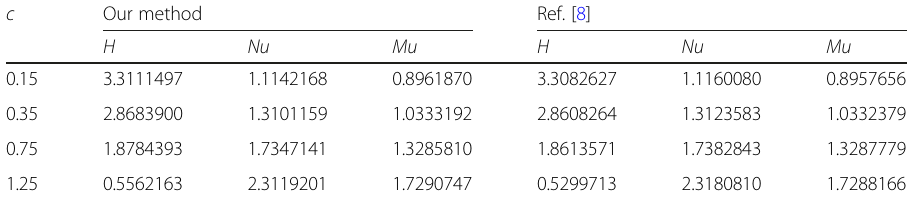
Table 9 Comparison of our method and Makinde [8] using different values of c and step size Δη =